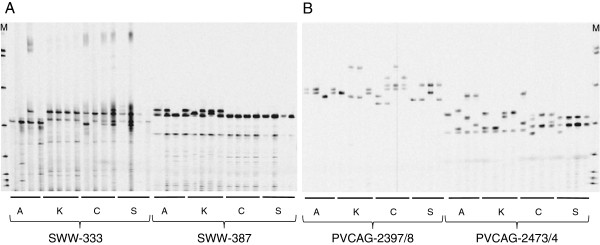
Polymorphisms of SSR primer pairs in a panel of 16 individuals. The panel was made from four cultivars, Alamo (A) Kanlow (K), Cimarron (C) and Summer (S), and each variety included four different genotypes. The lane with an “M” is DNA marker of 50-350 bp size standards (LI-COR Biosciences, Lincoln, NE, USA). A) Amplification from two EST-SSR markers, SWW-333 and SWW-387. B) Amplification from two genomic SSR markers, PVCAG-2397/8 and PVCAG-2473/4.